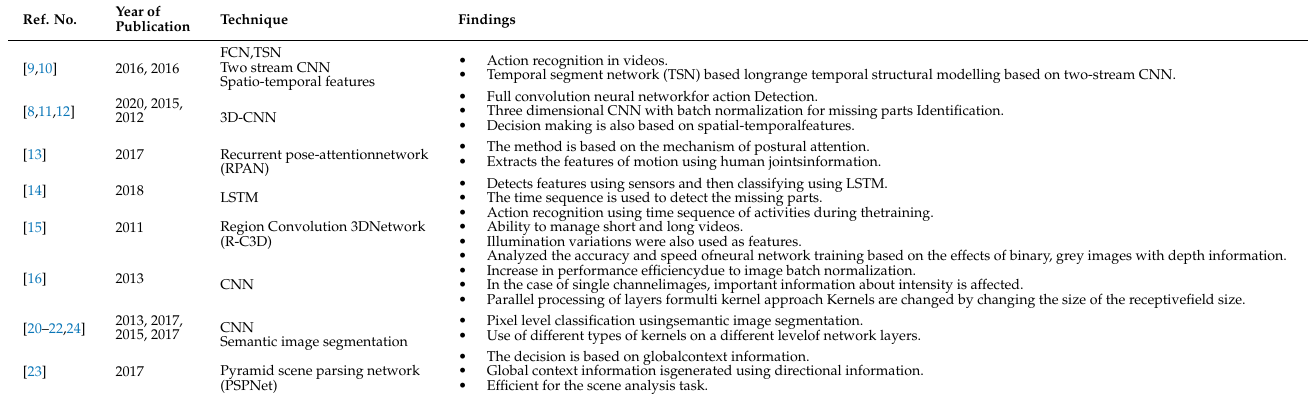
Table 1. Summarized table of literature